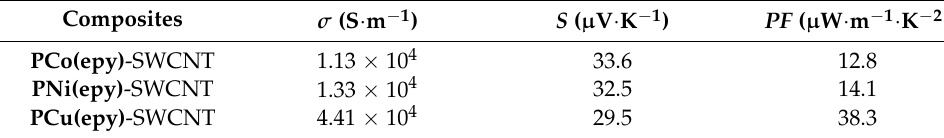
Table 2. The TE properties of the PM(epy) -SWCNT composites at f C = 75%.